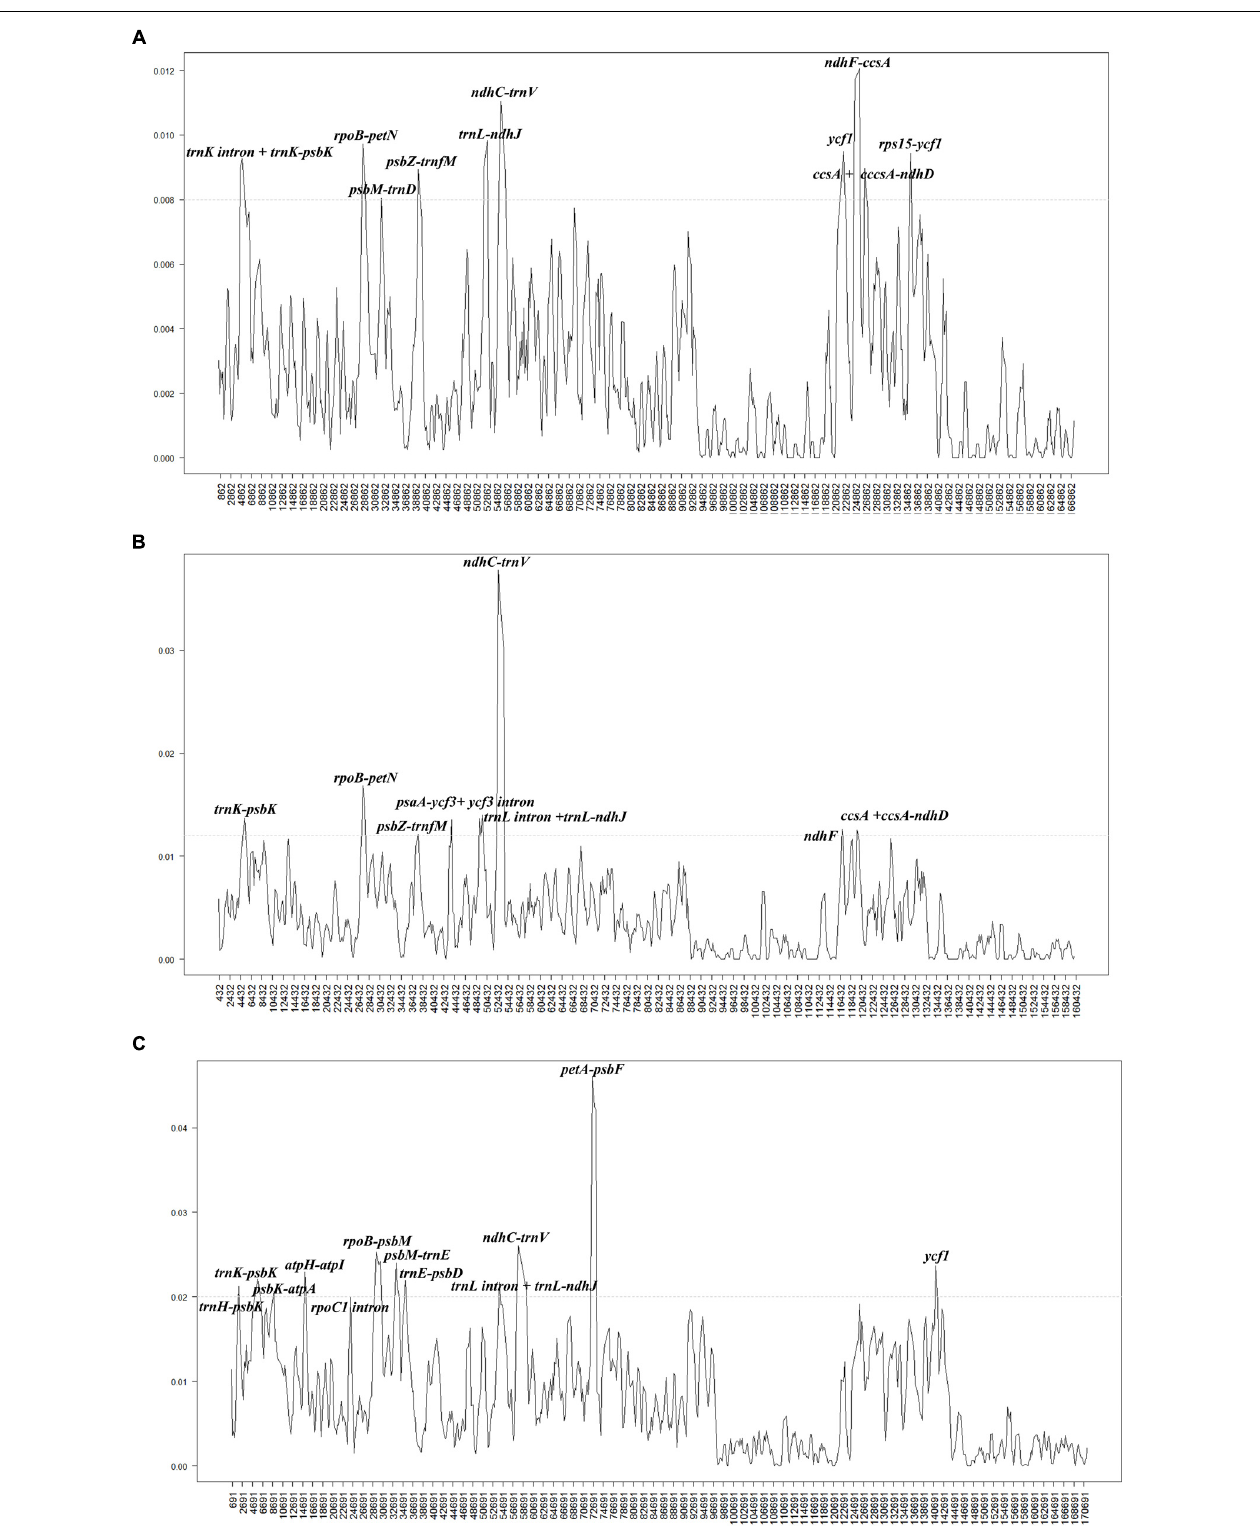
FIGURE 3 | Comparison of the nucleotide variability (Pi) values of the plastomes: (A) 40 plastomes of Populus , (B) fifteen plastomes of Salix , and (C) 55 plastomes of Populus and Salix . The genetic divergence was calculated with DnaSP 5.0 software (window length: 600 bp and step size: 200 bp). X -axis: position of the midpoint of a window, Y -axis: nucleotide diversity of each